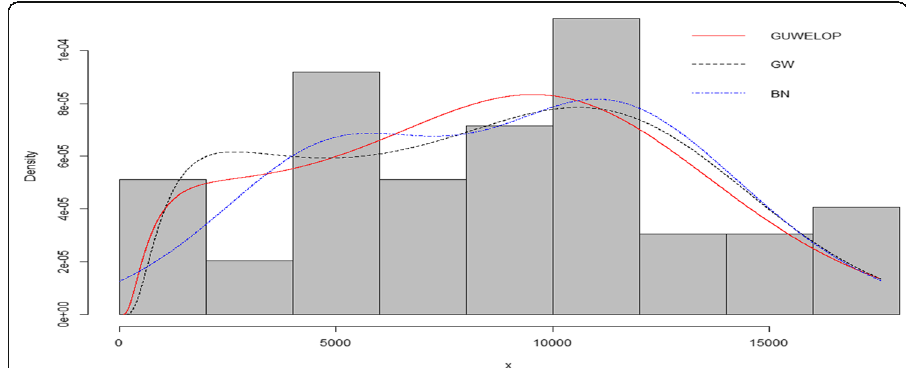
Fig. 2 Histogram and fitted densities of Kevlar 49/epoxy strands failure times data (pressure at